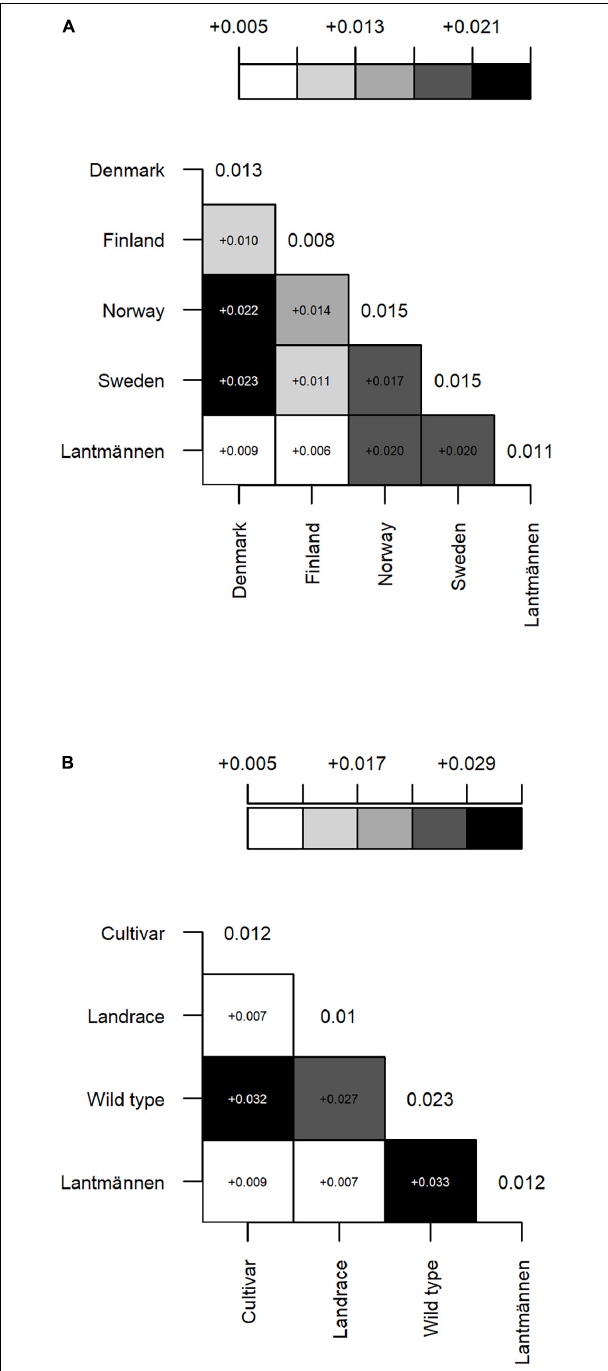
FIGURE 3 | A graphical illustration of pairwise F ST between groups of accessions representing different (A) country of origin: Sweden, Norway, Denmark, Finland and Lantmännen, and (B) population type: cultivar, landrace and wild populations from NordGen, and Lantmännen accessions. The gradient color intensity corresponds to low to high F ST values (the deeper the color the higher the F ST value). All values are significant at a threshold value of 0.05. F ST value of each pair is shown in the corresponding square. The diagonal values are mean F ST values of each group. Lantmännen is represented as a separate group under country of